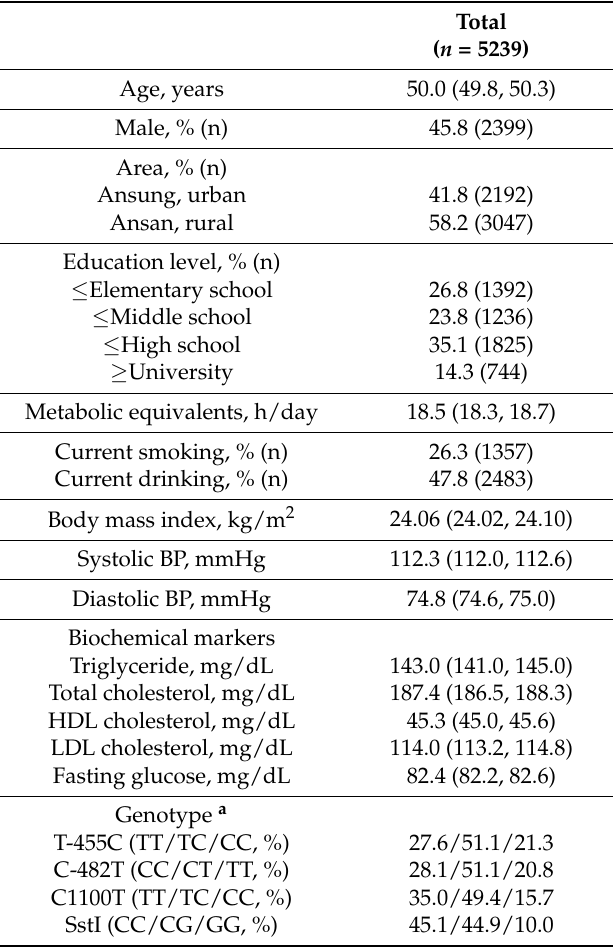
Table 1. General characteristics of the population at